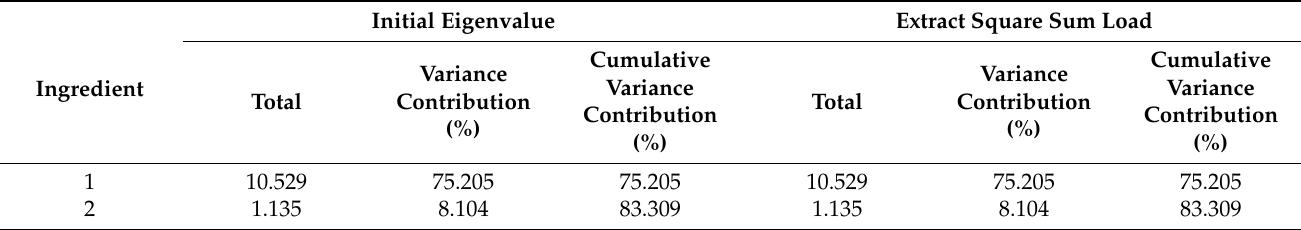
Table 3. The eigenvalues and variance contributions of the principal